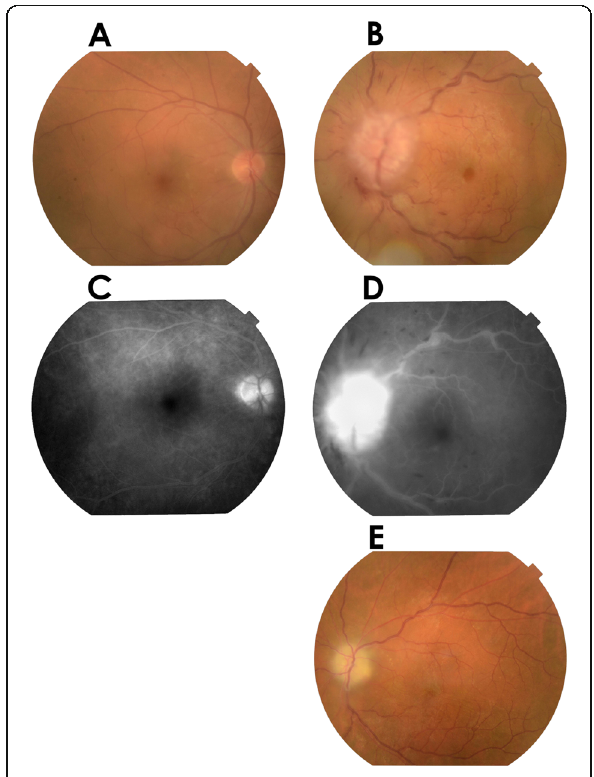
Fig. 1 Fundus photograph and fluorescein fundus angiography. Seen in a fundus photograph taken during the initial visit, the right eye shows no abnormality in the post pole ( a ). Left eye shows severe disc edema and hyperemia, and engorgement of all branches of the central retinal vein, dot, and flame-shaped hemorrhages ( b ). Results of fluorescein fundus angiography taken during the initial visit indicate no abnormality in the right eye ( c ). Left eye shows hyperfluorescein in the optic disc ( d ). Seven months later, the optic disc turned pale in color, and retinal hemorrhages disappeared ( e )